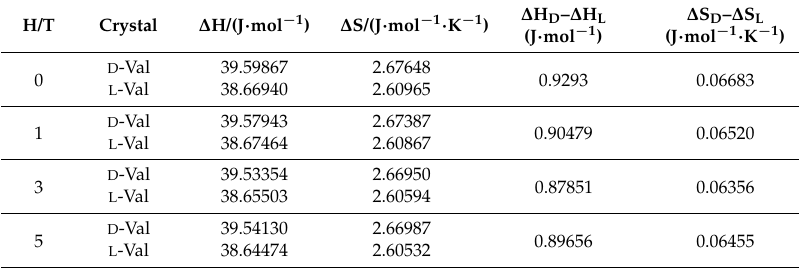
Table 3. Magnetic-field dependence of ∆ H and ∆ S in D - and L -valine crystals from 2–20 K.